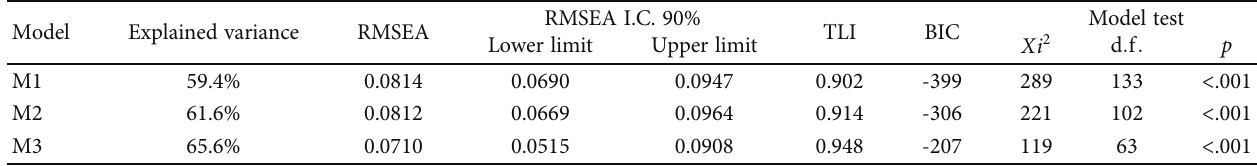
Table 6: Results of the exploratory factor